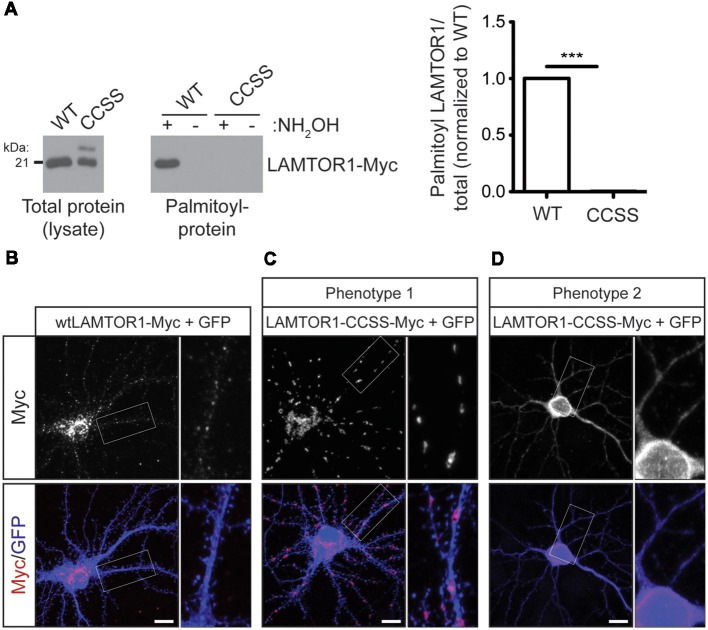
Palmitoylation is required for LAMTOR1 localization in hippocampal neurons. (A) Mutation of cysteines 3 and 4 in Myc-tagged human LAMTOR1 (LAMTOR1-CCSS-Myc) abolishes its palmitoylation. Total expression (left panel) and palmitoyl-levels (right panel) of WT or CCSS LAMTOR1-Myc isolated from transfected HEK293T cells. Right histogram shows quantified palmitoyl/total LAMTOR1 levels (Student’s t-test with Welch’s correction, *** < 0.001, N = 3). (B) Hippocampal neurons were transfected to express wtLAMTOR1-Myc and morphology marker GFP. First
column: images of Myc and merged images of Myc/GFP signals. Second column: magnified views of the boxed area of first column images. (C,D) As in A except that neurons were transfected with LAMTOR1-CCSS-GFP. (C) Phenotype 1 of LAMTOR1-CCSS-Myc, observed in approx. 85% of neurons and (D) phenotype 2 of LAMTOR1-CCSS-Myc, observed in approx. 15% of neurons. Scale bar indicates 10 μm.